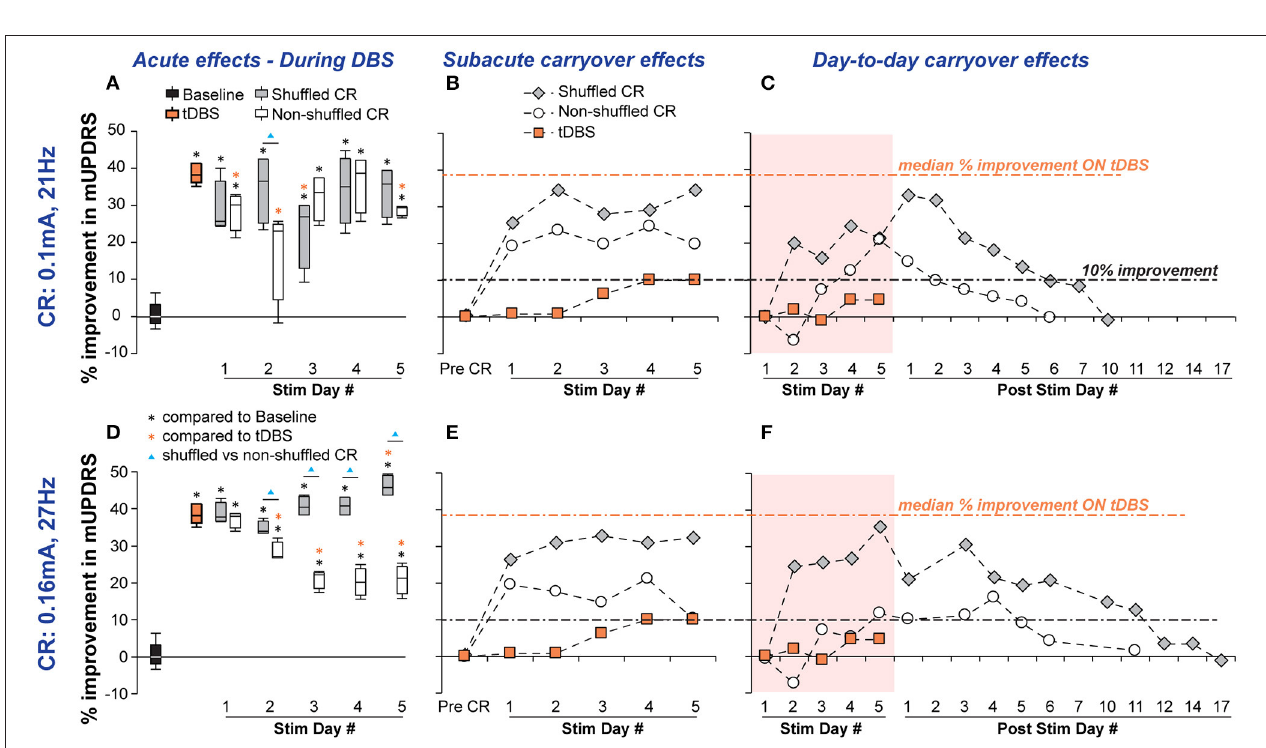
FIGURE 2 | Acute and carryover improvements in mUPDRS acquired by shuffled and non-shuffled CR DBS in NHP J. (A) Acute improvements were compared with the baseline using the Steel’s test with control = Baseline (* p < 0.05) following a Wilcoxon test. Daily acute improvements of CR DBS were also compared to traditional DBS (tDBS) using the Steel’s test with control = tDBS (* p < 0.05). Within each stimulation day, the shuffled and non-shuffled CR DBS were compared using the Wilcoxon test ( N p < 0.05). (B) Subacute carryover effects of CR DBS indicated by the percentage improvement in the post-DBS mUPDRS. (C) Day-to-day carryover effects of CR DBS indicated by the percentage improvement in the daily morning mUPDRS on stimulation and post-stimulation days.